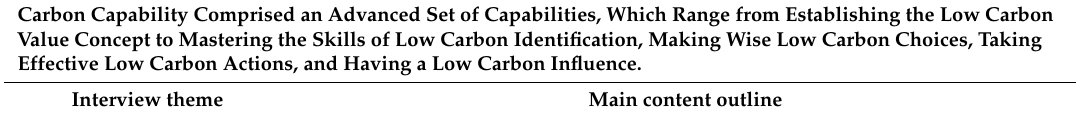
Table 1. Outline of the open-ended